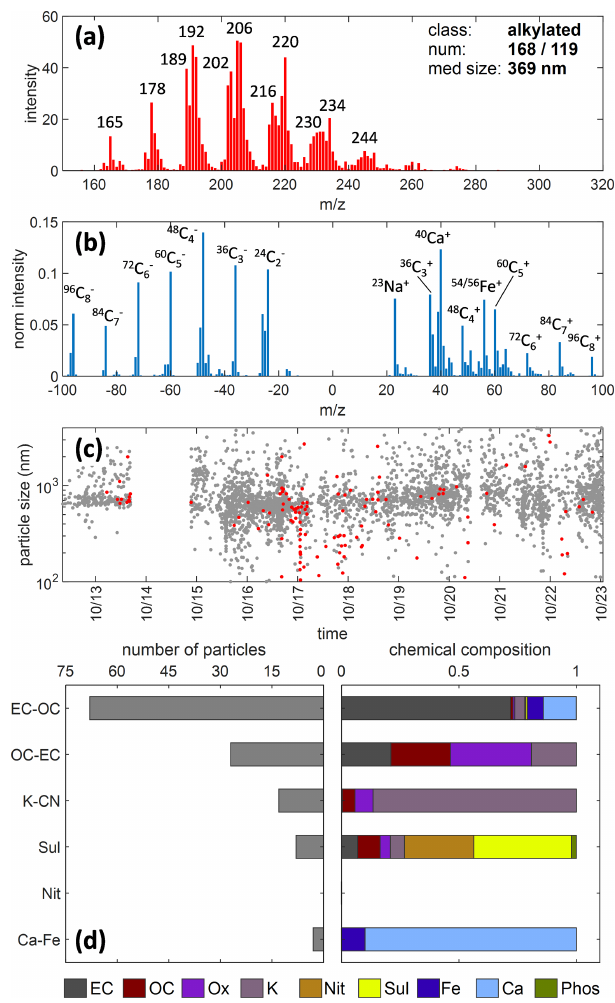
Figure 9. Particles with dominant signals from alkylated phenan- threnes were observed during onshore wind periods. These rather small particles reveal soot and Ca + but nearly no secondary mate- rial. They can be attributed to ship traffic with distillate fuels such as marine gas oil. (For figure explanation, see Fig.